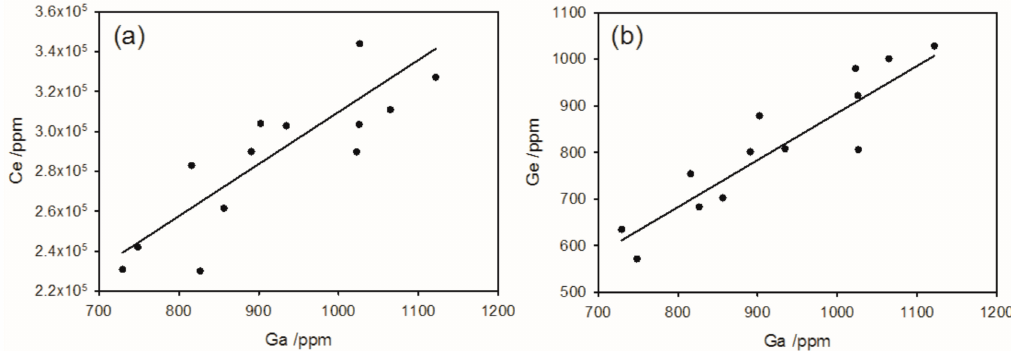
Figure 6. ( a ) Gallium and ( b ) germanium in